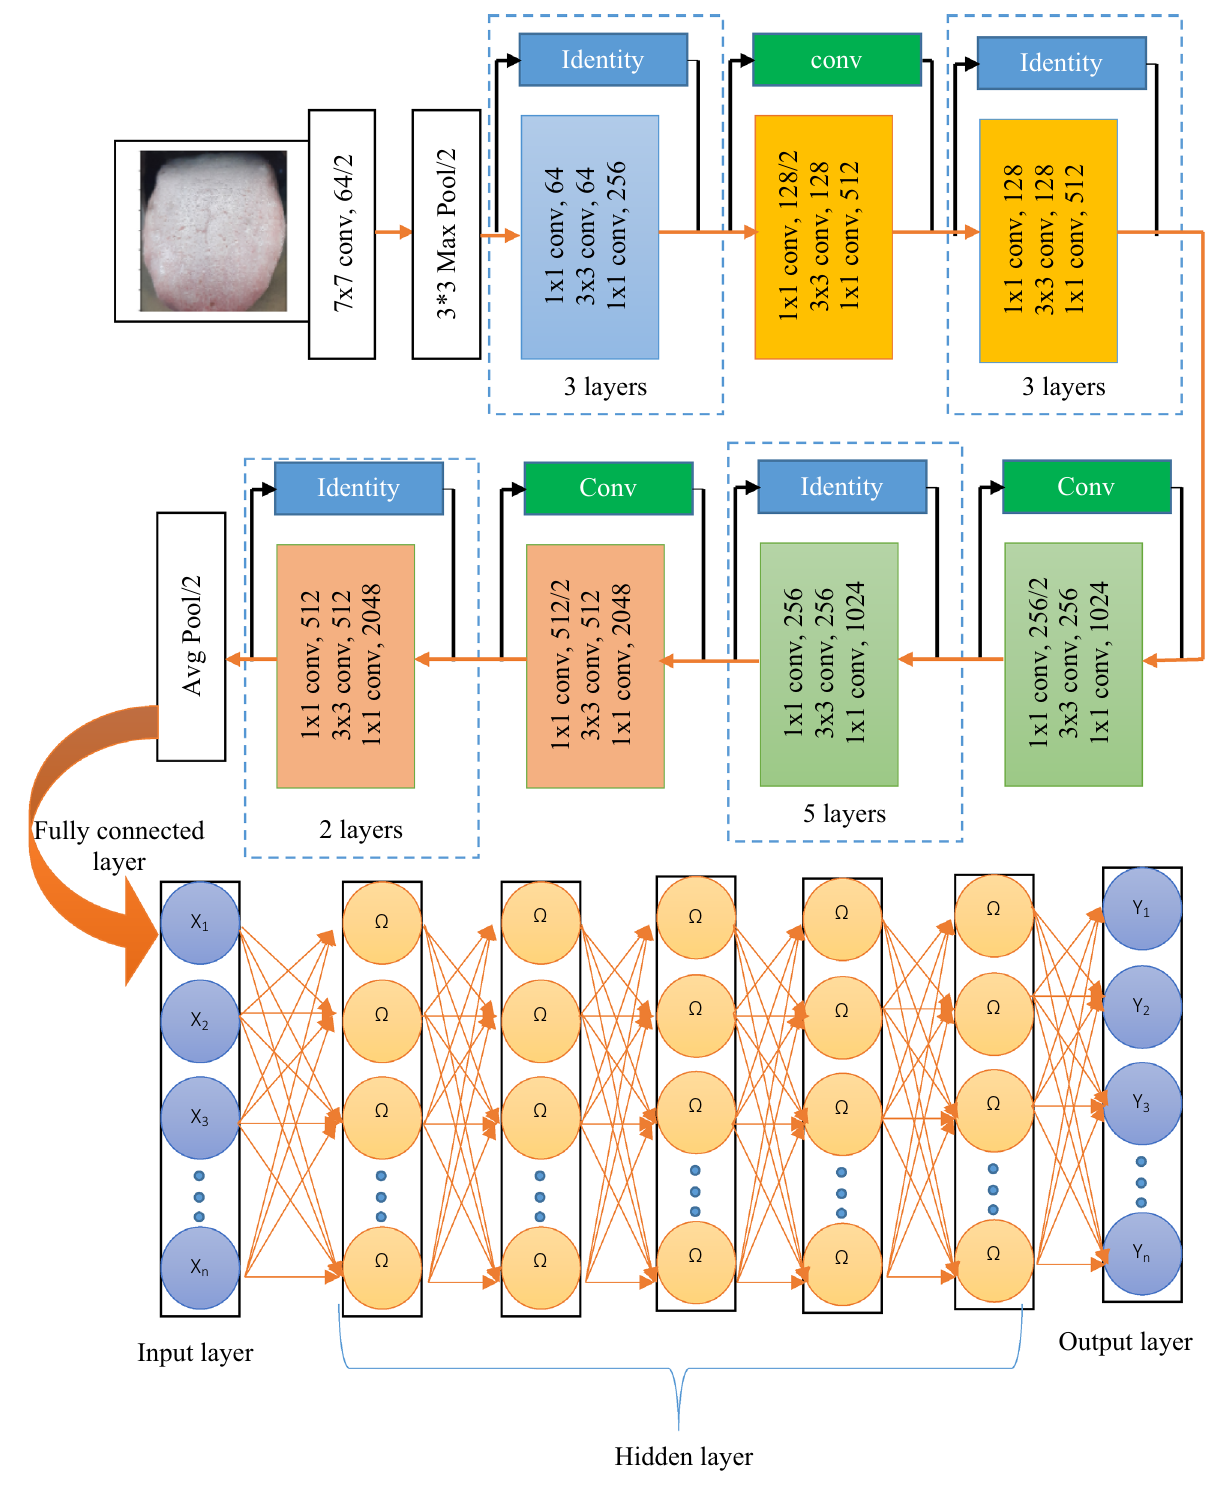
Figure 3. Machine learning architecture of deep CNN-RBFNN for tongue